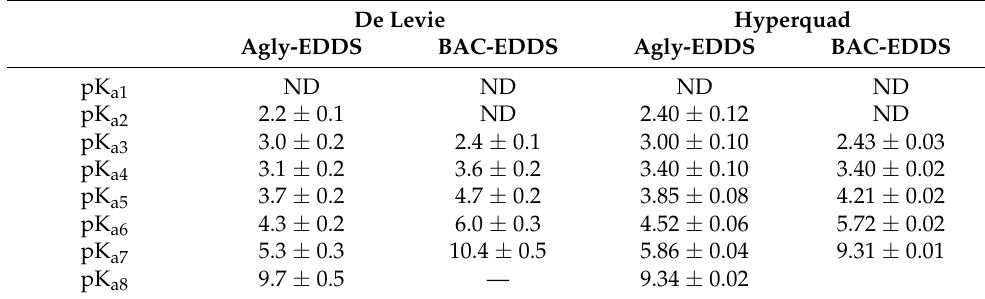
Table 2. Protonation constants for Agly-EDDS and BAC-EDDS (25 ◦ C, 0.1 M KCl, N 2